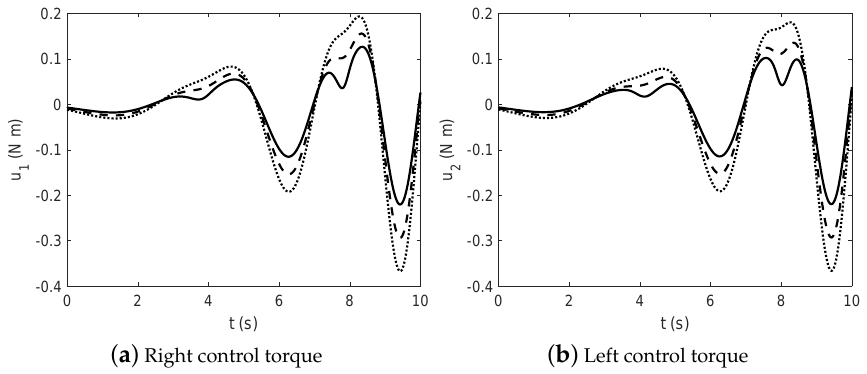
Figure 5. Control actions. Initial conditions 1 (solid lines), initial conditions 2 (dashed lines), initial conditions 3 (dotted